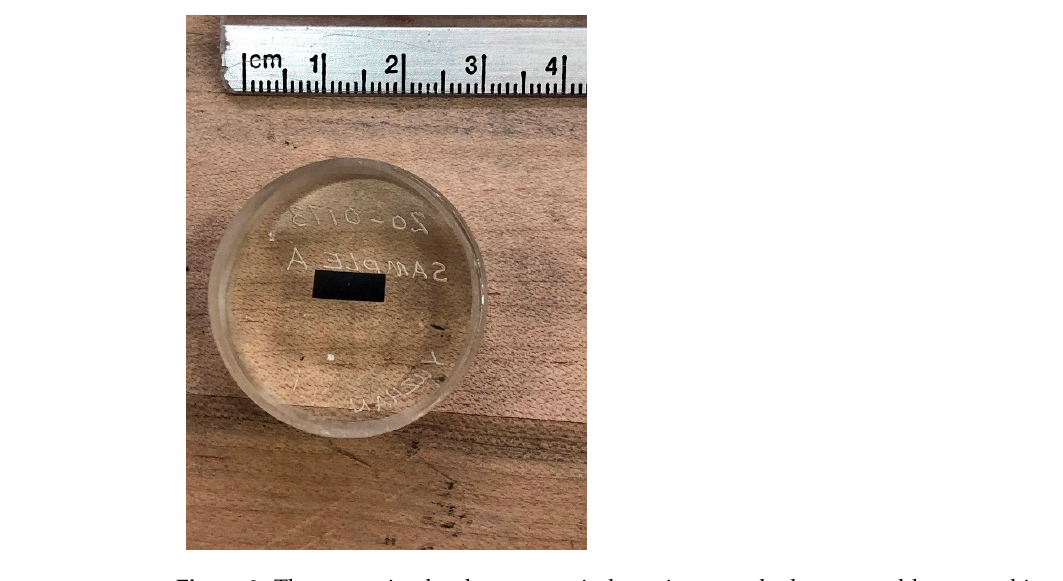
Figure 2. The as-received polymer nanoindentation sample that was cold mounted in epoxy and polished to a mirror finish.